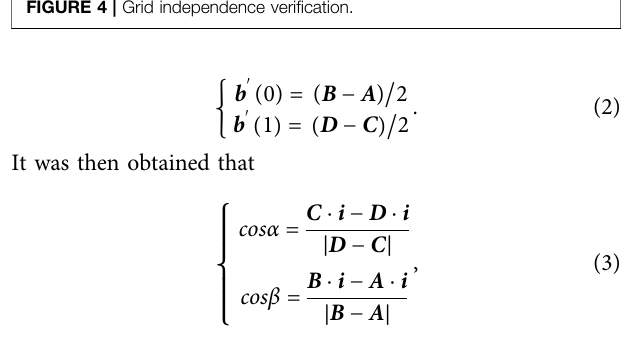
FIGURE 4 | Grid independence veri fi cation.